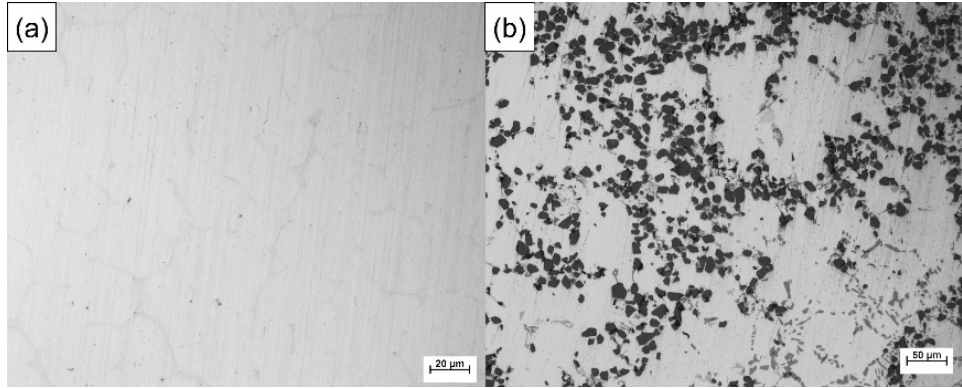
Figure 1. Optical metallographic diagram of 7050 alloy ( a ) and 15 wt.%SiCp/A357 composite ( b ).